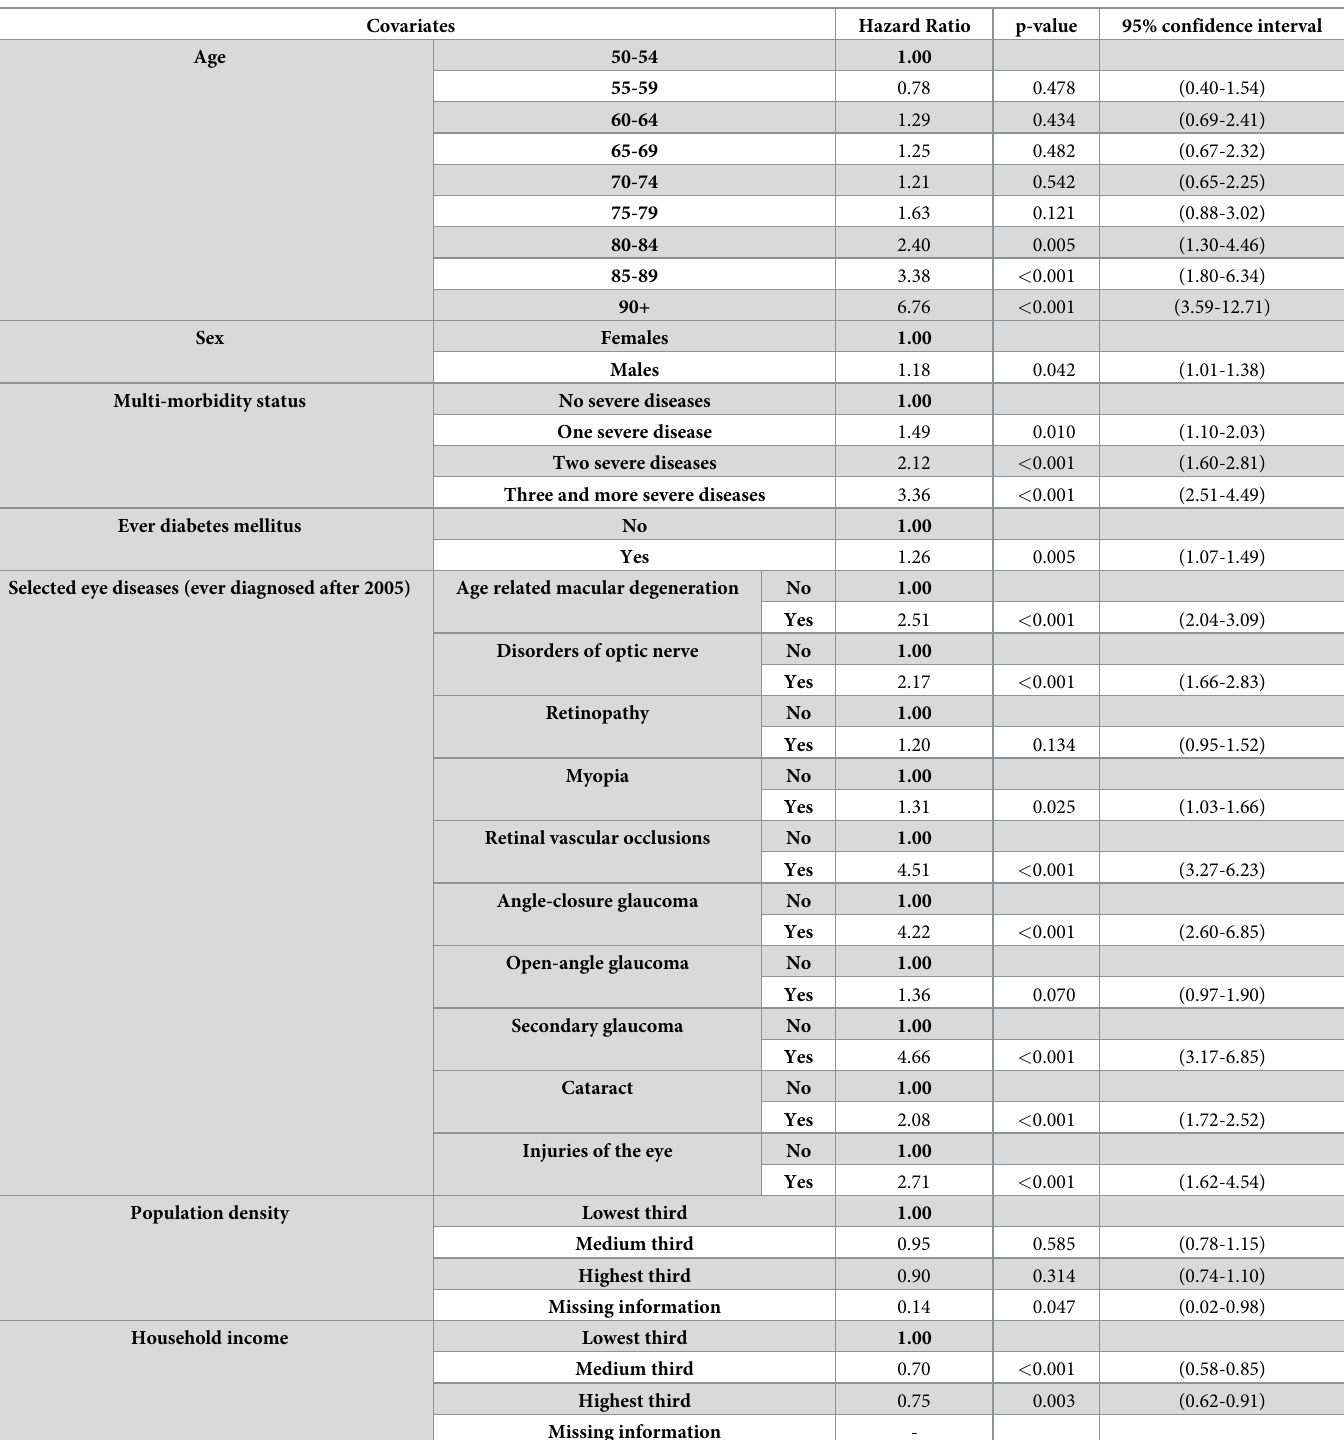
Table 3. Results of the Cox regression models, 2006-2015, Sample II, AOK